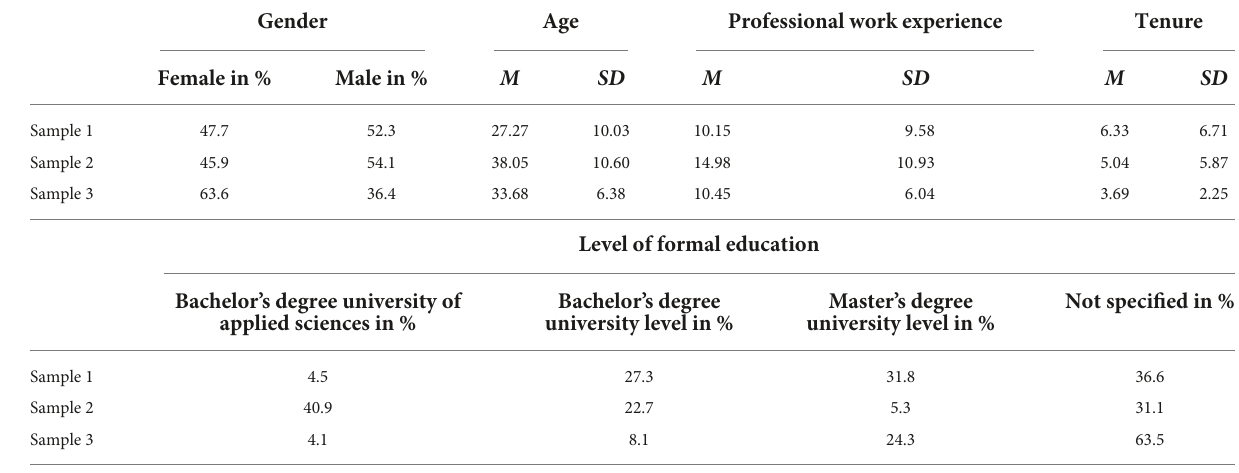
TABLE 1 Demographic information per